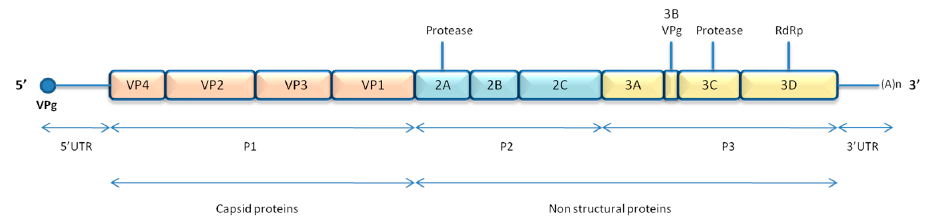
Figure 1. Enterovirus genome organisation.